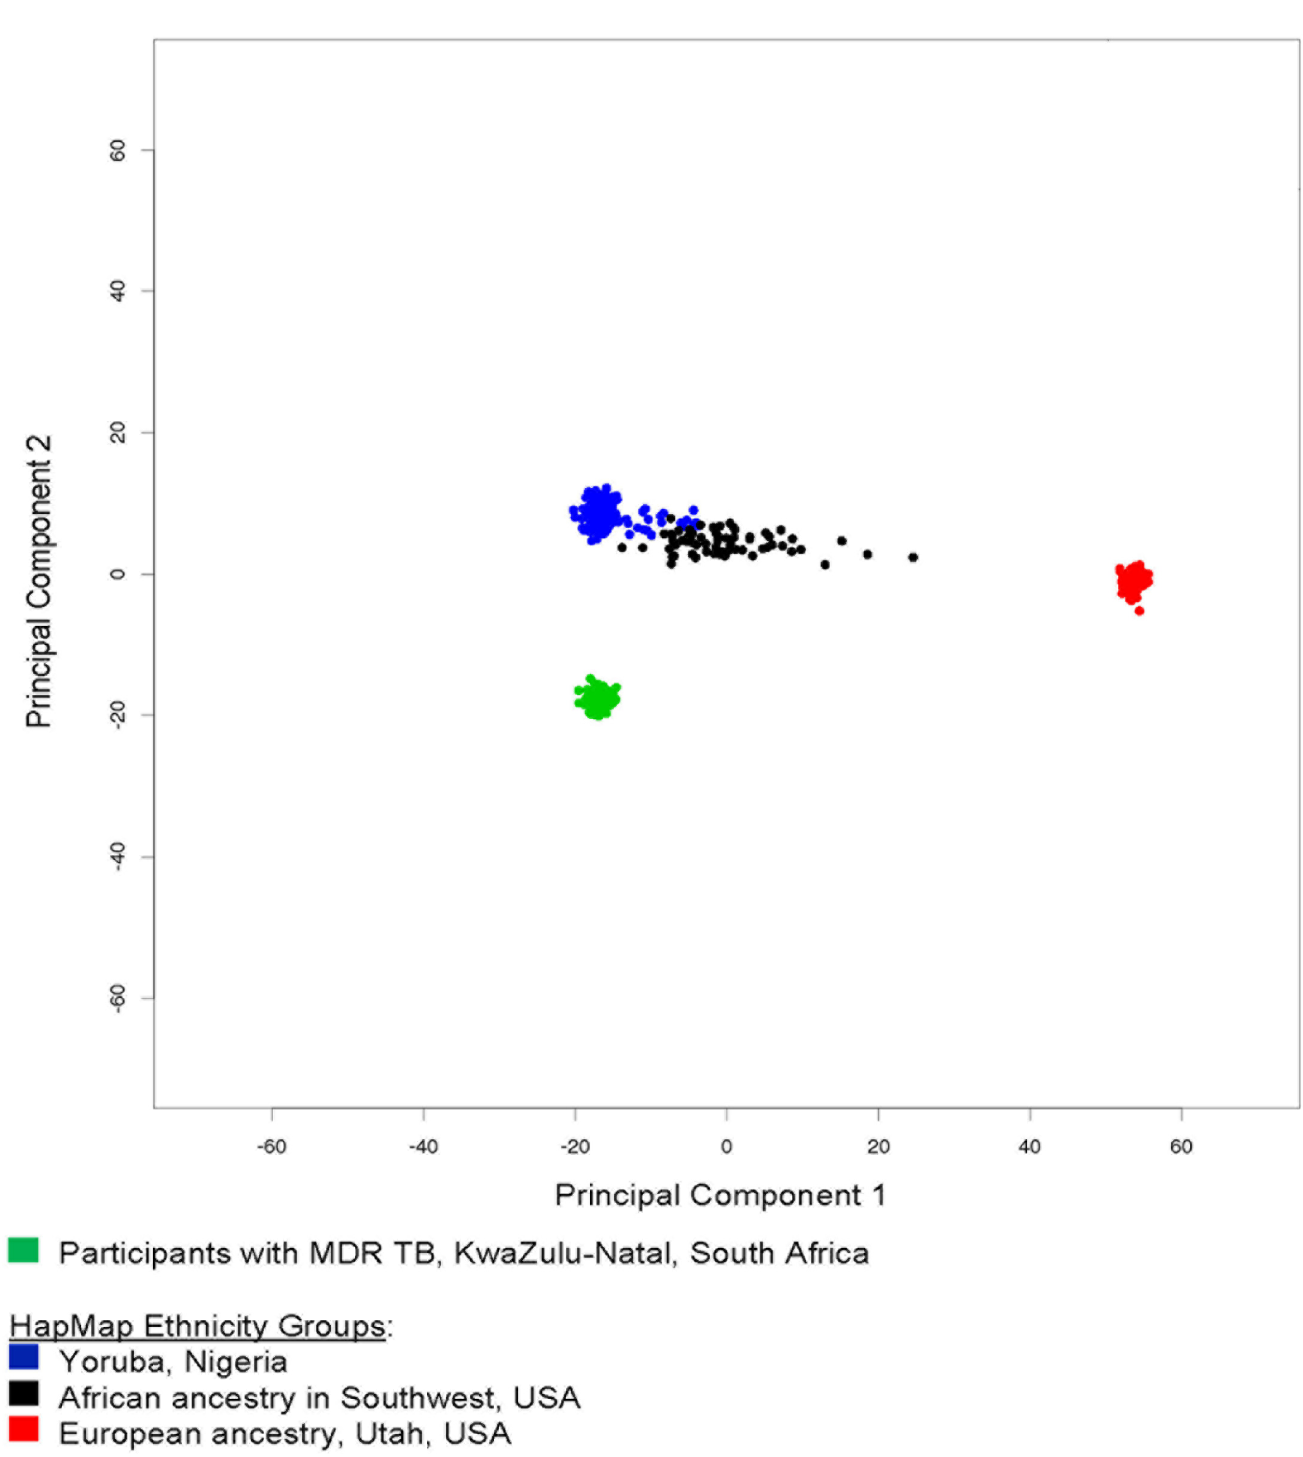
Fig 1. Principal component analysis of study participants compared to HapMap ethnic groups.